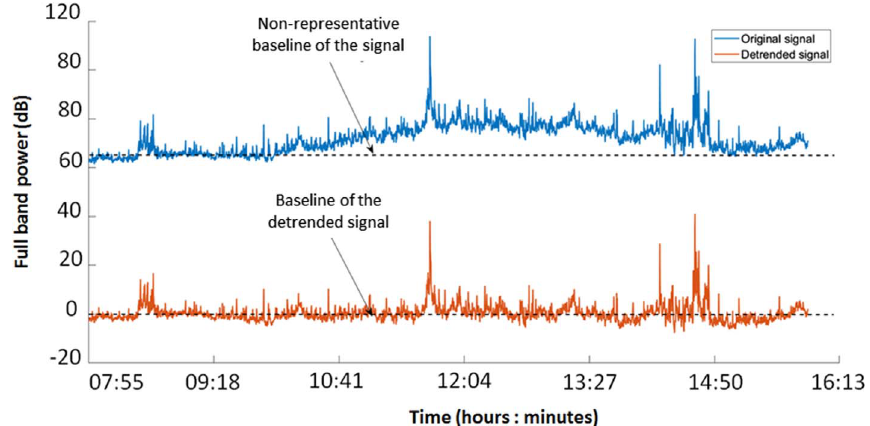
Fig. 12. Solar signal before and after